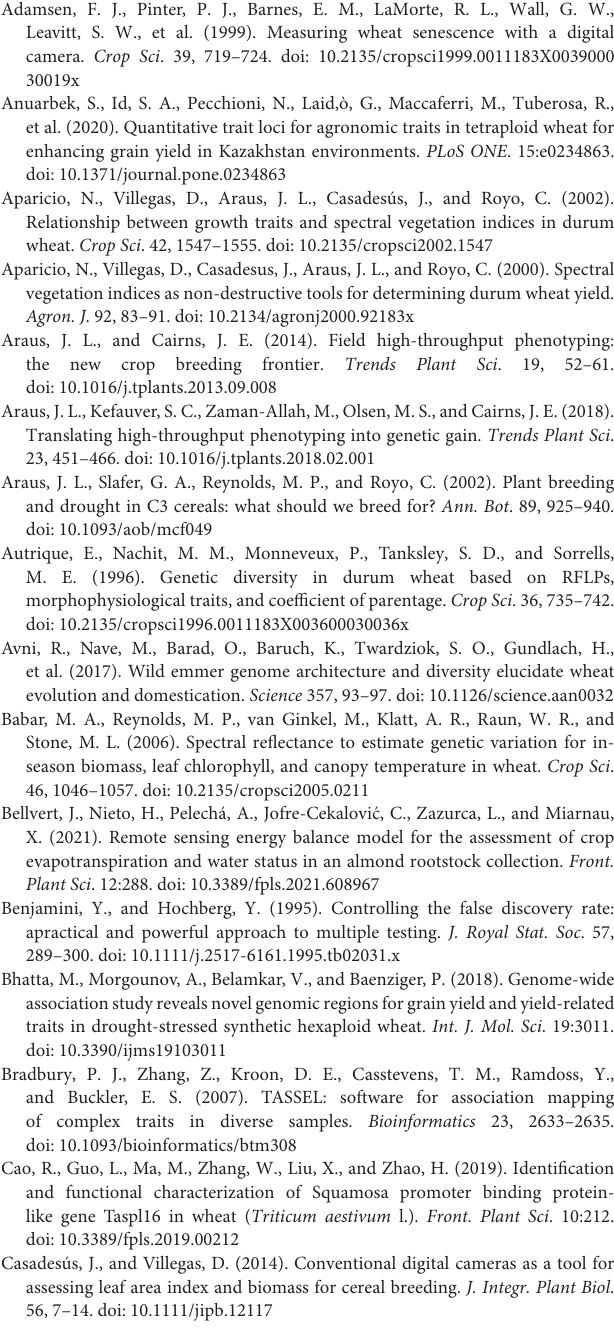
Supplementary Table 1 | Genotypes used in this study. Supplementary Table 2 | Phenotypic values of the analyzed traits for the 3 years of field trials. Supplementary Table 3 | Boxplots and summary statistics for the analyzed traits. Coefficients of variation for agronomic traits among the 3 years are included.